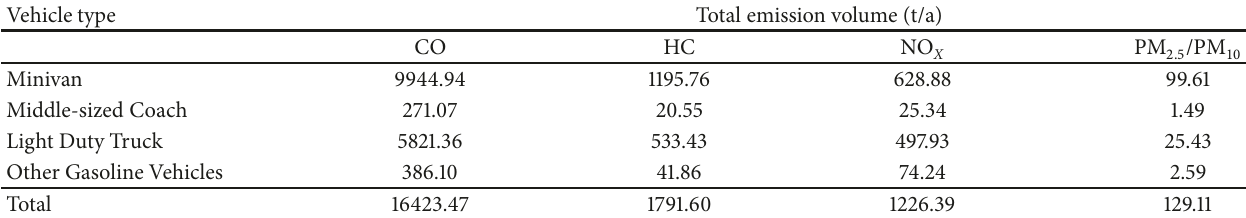
Table 13: Pollutant emission inventory of gasoline vehicle in Zibo City referring to average emission factors.